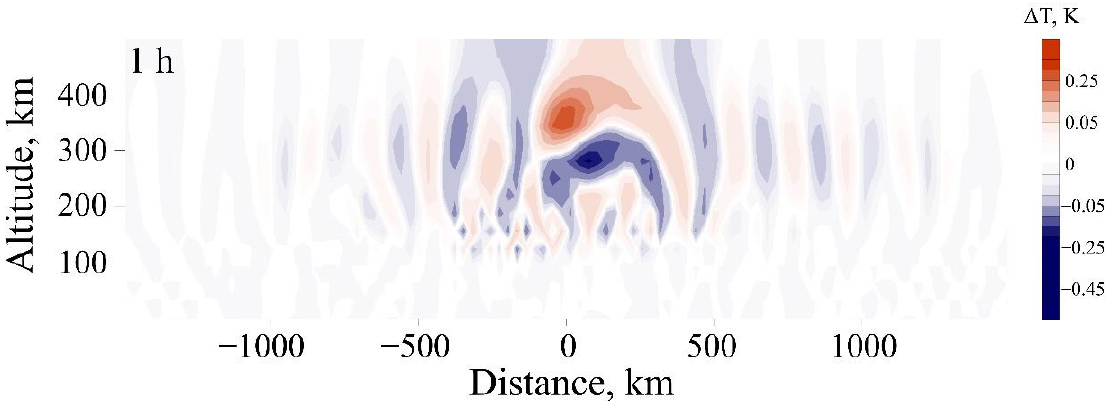
Figure 5. Results of numerical calculations change in the temperature field for 1 h from the start time of calculations.